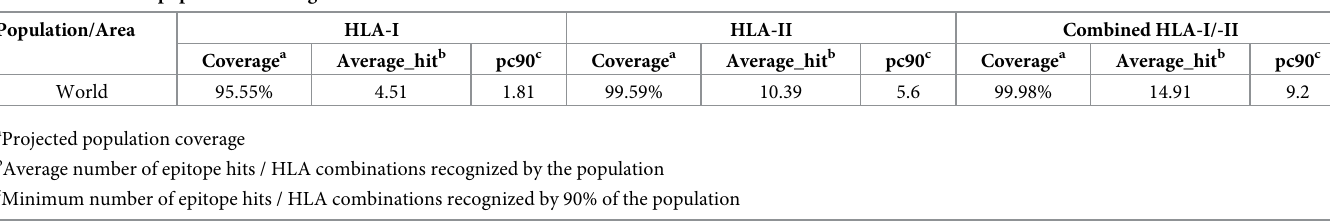
Table 5. Estimated population